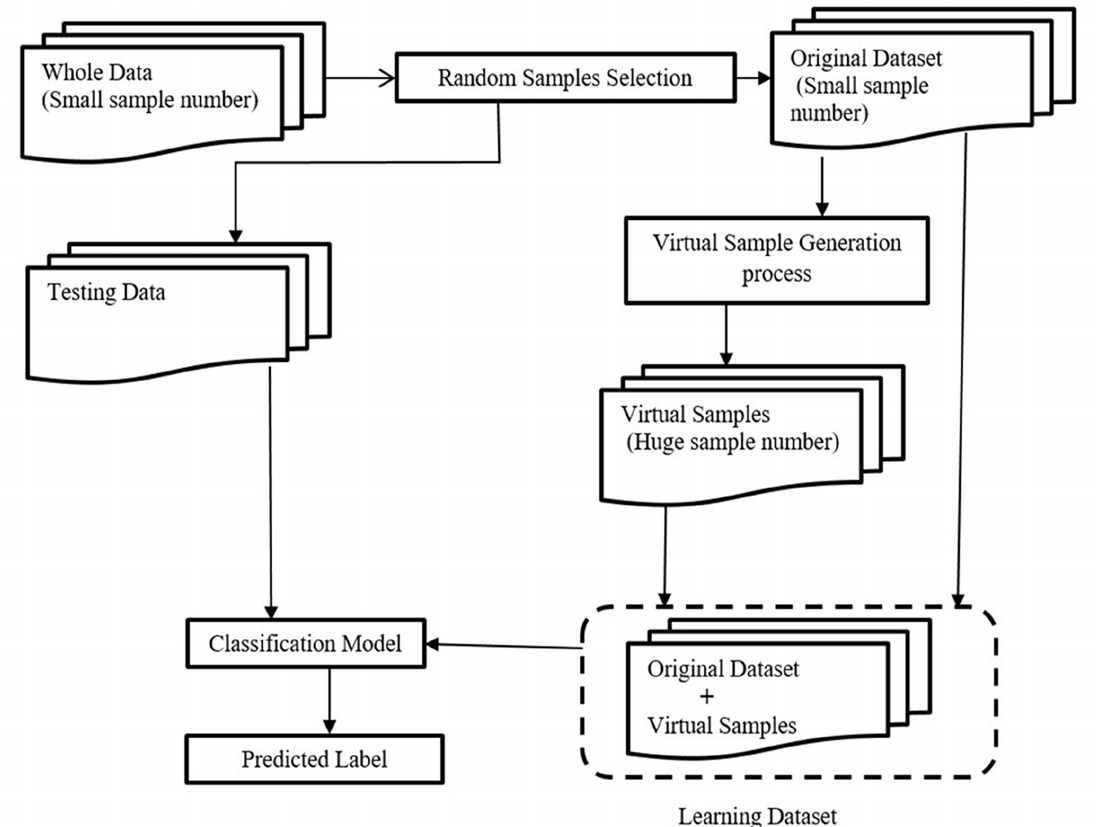
Figure 1. Flowchart of the whole procedure with three different steps: (1) selection of a small sub-sample from the entire dataset and the remaining samples used as testing data; (2) application of the VSG method depending on the selected samples from the first step; (3) data prediction and